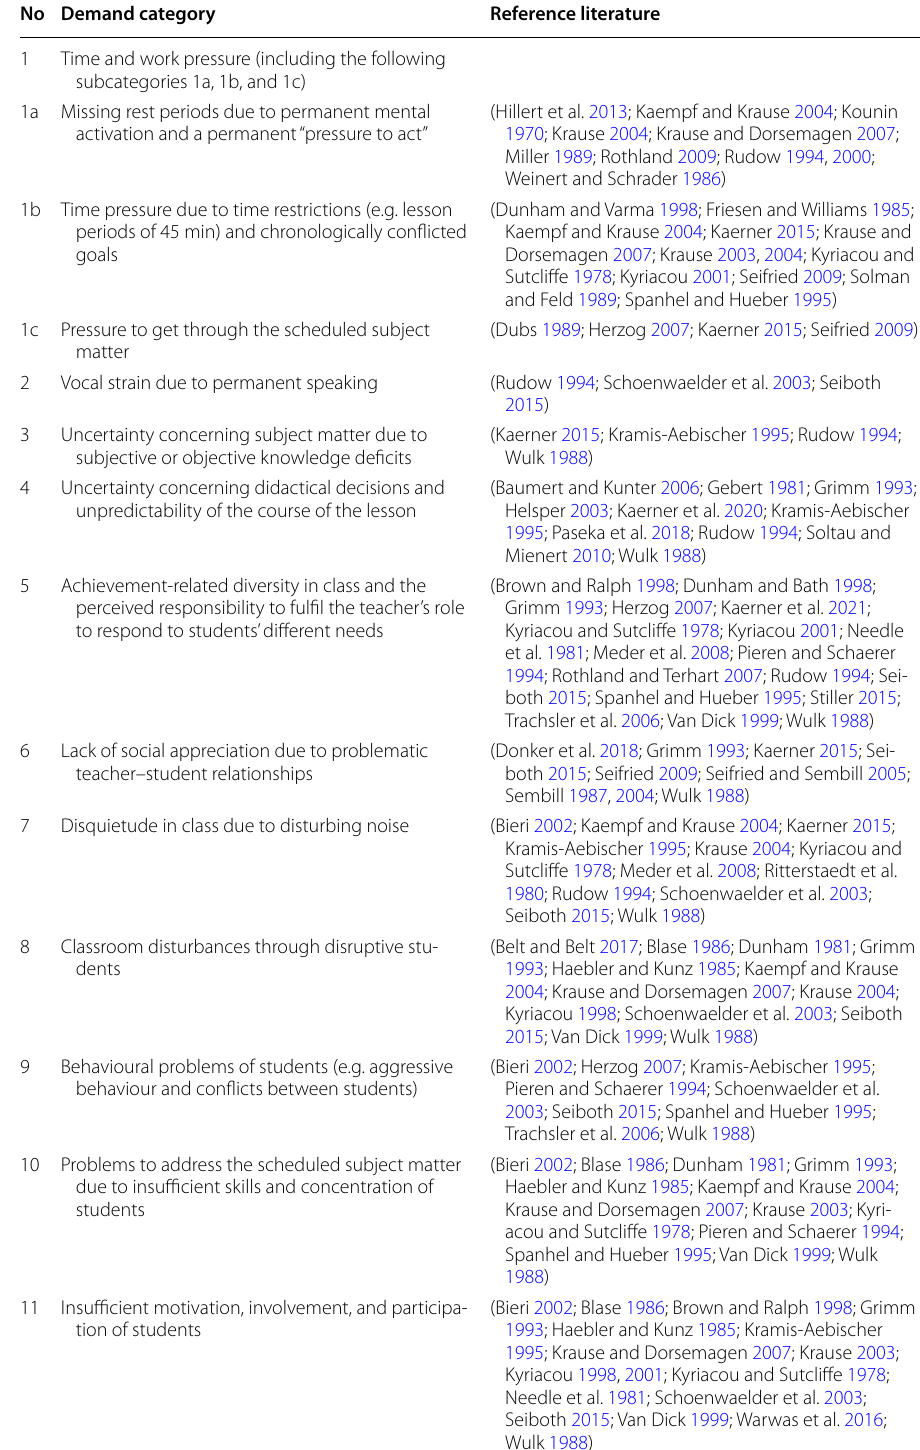
Table 1 Literature review on teachers’ situational classroom demands No Demand category Reference